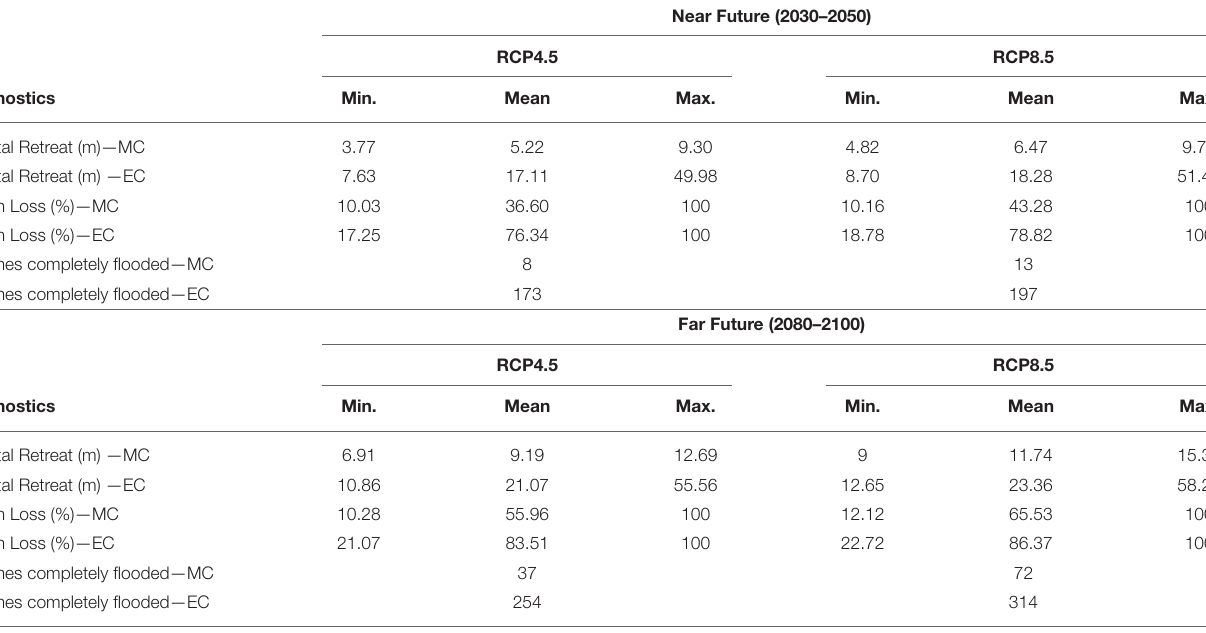
TABLE 1 | Summary of the coastal retreat (in m) and beach area loss for all the beaches in the Balearic Islands. Near Future (2030–2050) RCP4.5 RCP8.5 Min. Mean Max.